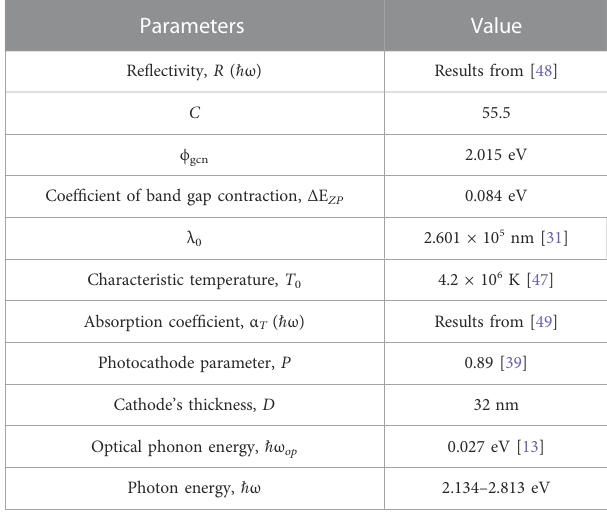
TABLE 3 Parameters used to calculate QE from Eq.